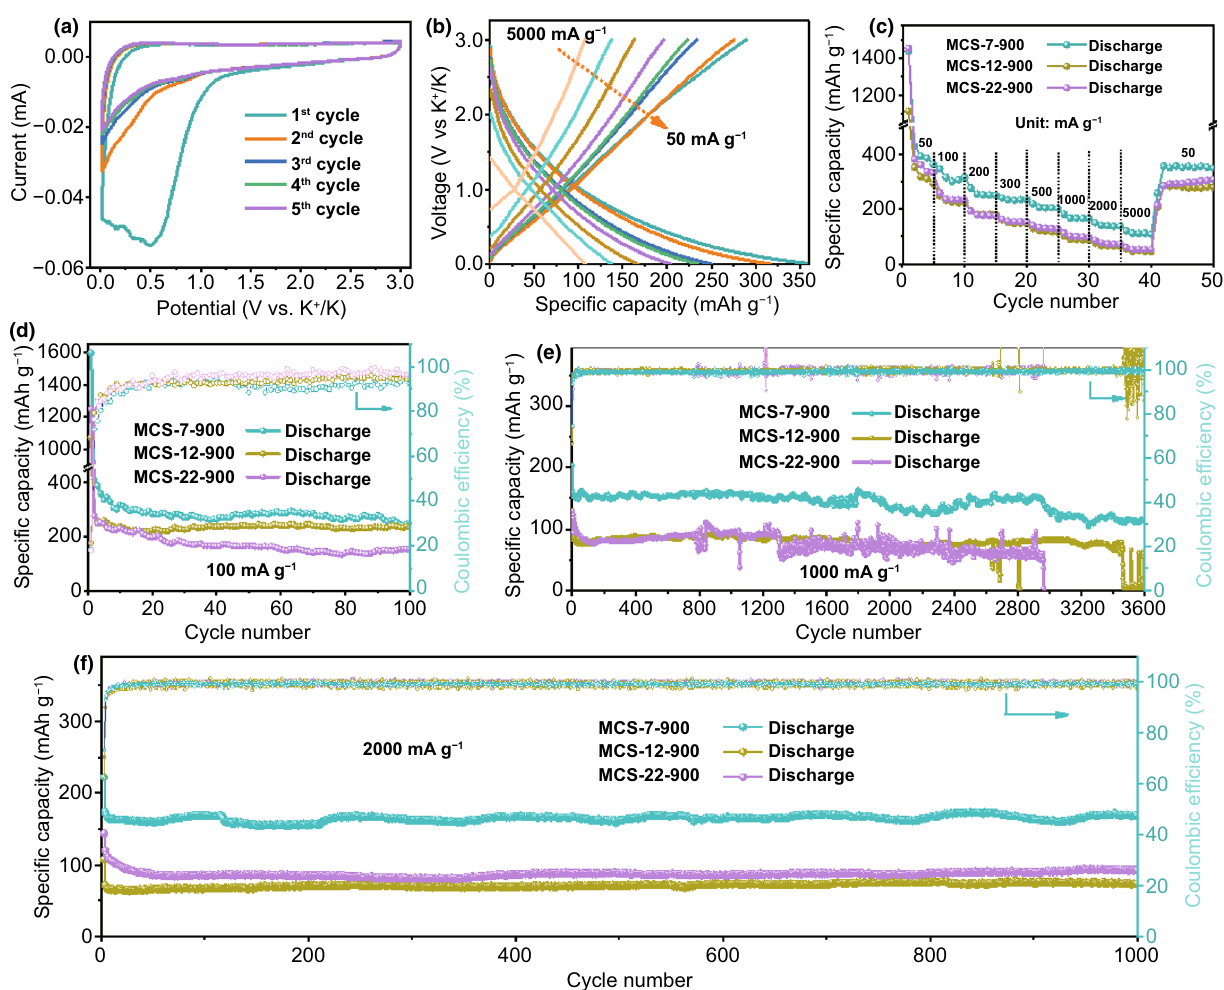
Fig. 3 a CV profiles scanned at 0.1 mV s −1 and b the charge–discharge profiles in the range of 50–5000 mA g −1 of the MCS-7-900 electrode. Comparison of electrochemical performances of MCS-7-900, MCS-12-900 and MCS-22-900: c Rate performance; d Cycle performance at the current density of 100 mA g −1 ; Long-cycling performance at e 1000 mA g −1 and f 2000 mA g